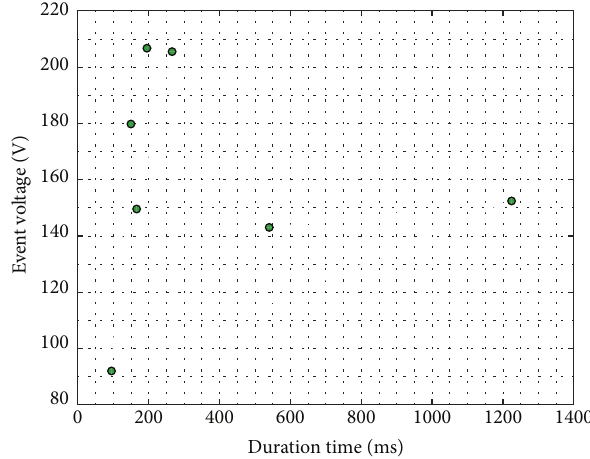
Figure 11: Occurrences of voltage dips and voltage swells for the first facility. The green circles represent the minimum values below the lower limits and the red circles represent the maximum values above the upper limits imposed by the standard.